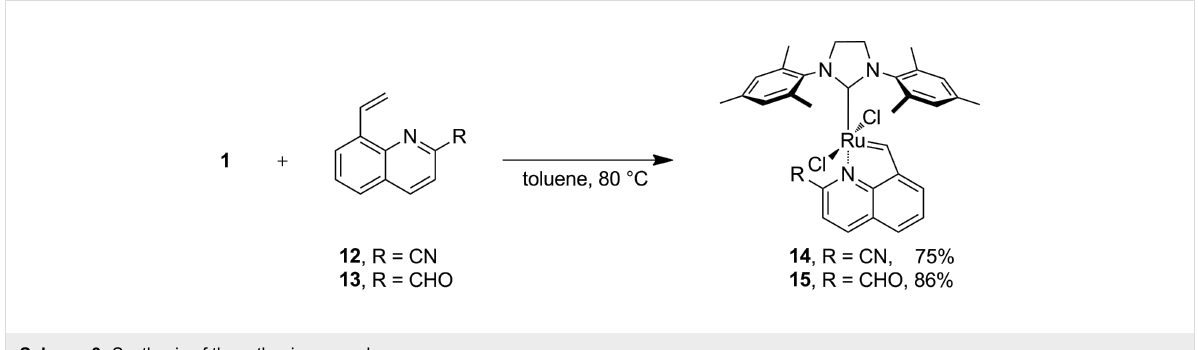
Scheme 3: Synthesis of the ruthenium